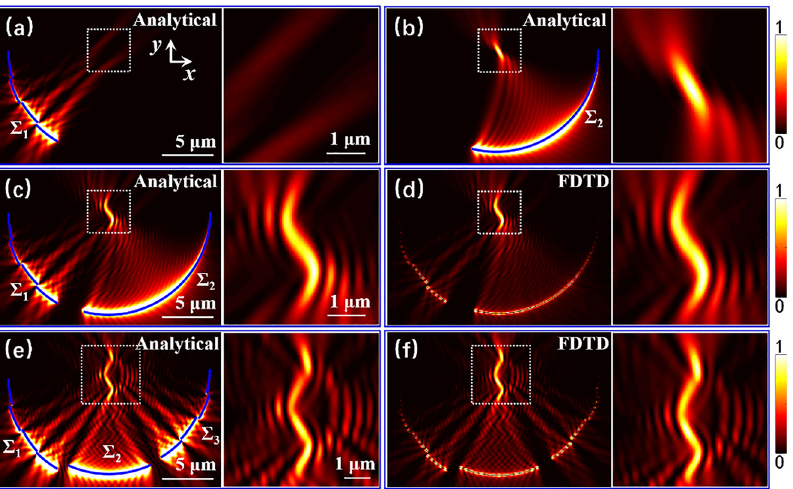
Figure 2: Structured SPP focal fields excited by plasmonic metalens structures marked by blue solid lines. (a) and (b) SPP fi eld distribution excited by a plasmonic lens Σ 1 and a plasmonic lens Σ 2 , respectively. The plasmonic lens Σ 1 is a double-layer gratingstructure,whoseradiusoftheinnerandouterslitsare R − λ spp /4and R + λ spp /4( R =10 μ m),respectively.Andtheangularperiodof Σ 1 is p =30 ° .Theplasmoniclens Σ 2 isasingleslitwitharadiusof R − λ spp /4.For Σ 1 and Σ 2 ,theopeninganglesare α =60 ° and105 ° ,respectively.(c) Analyticalresultand(d)FDTDsimulationresultofanS-shapedSPP fi eldgeneratedbyametalenscomposedoftwoplasmoniclenses Σ 1 and Σ 2 . All parameters are as in (a) and (b). (e) Analytical result and (f) FDTD simulation result of a W-shaped SPP fi eld generated by a metalens composed of three plasmonic lens Σ 1 , Σ 2 , and Σ 3 . The opening angles of Σ 1 , Σ 2 , and Σ 3 are α = 60 ° , 48 ° , and 60 ° . For Σ 1 and Σ 3 , the radius of the inner and outer arcs-shaped slits are R − λ spp /4 and R + λ spp /4, respectively, and the angular periods are both p = 30 ° . The radius of Σ 2 is R − λ spp /4. To make the W-shaped SPP pattern more continuous, the structures Σ 1 and Σ 3 are shifted with a distance of − λ spp and λ spp in the y - direction, respectively. All other parameters are as in Figure